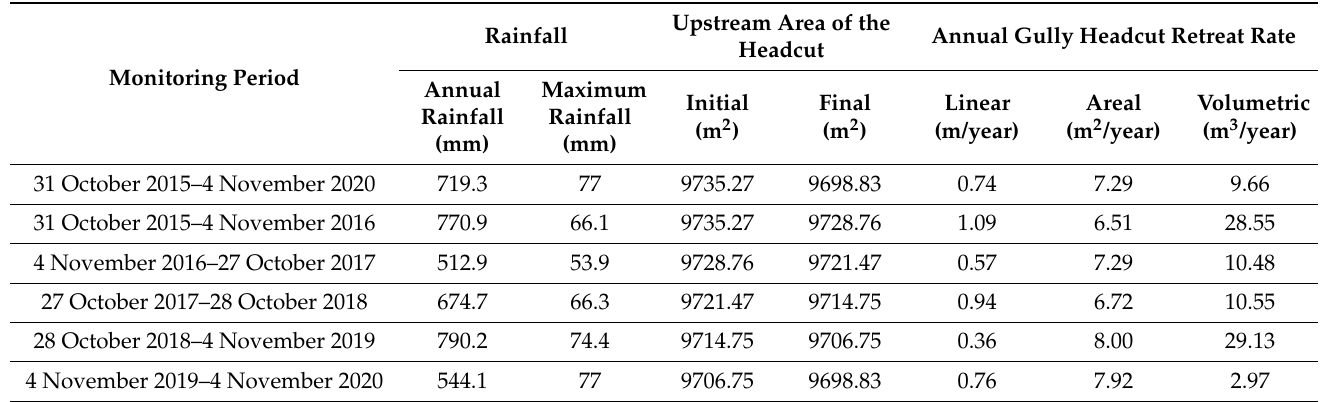
Table 4. Variations in the gully headcut retreat rate and environmental